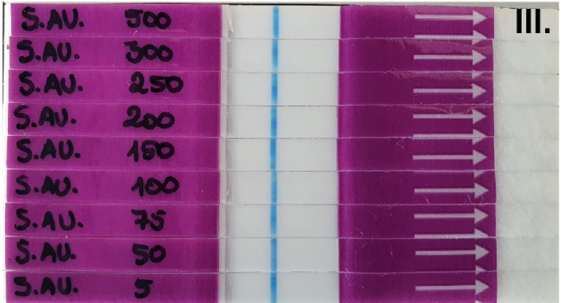
Figure 3. LF strip optimization. Determination of the optimal LF-TTprobe concentration. I . TSB and II . S. epidermidis ATCC 35984 were used as control medium and bacterium, respectively, allowing for determination of the limit of visible detection for both lines, as a negative result in our system. III . S. aureus ATCC 29213 was used as the target pathogen to obtain a positive result. The blue line represents the strip’s Control line, red line represents the strip’s Test line.